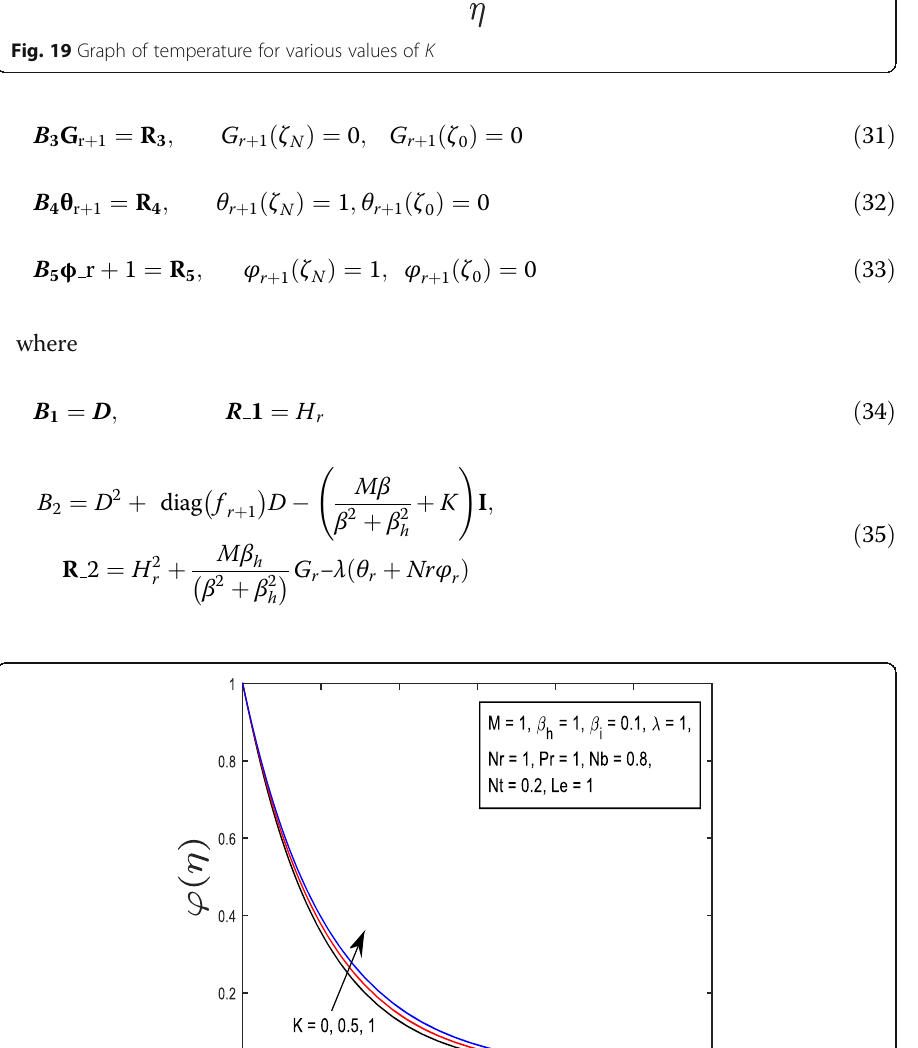
Fig. 19 Graph of temperature for various values of K